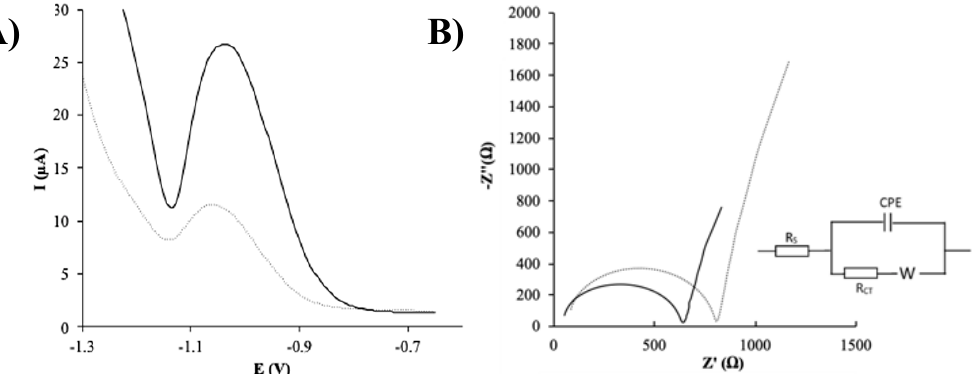
Figure 3. ( A ) Di ff erential pulse anodic stripping voltammetric (DPASV) measurements of bare-SPCNFE and Ag-NS-SPCNFE sensors obtained for 50 and 25 µ g L − 1 of As(V) in 0.01 mol L − 1 HCl pH 2, respectively. ( B ) Nyquist diagram for bare-SPCNFE and Ag-NS-SPCNFE in 5 mmol L − 1 K 3 [Fe(CN) 6 ] and 0.1 mol L − 1 KCl with the corresponding equivalent circuit.